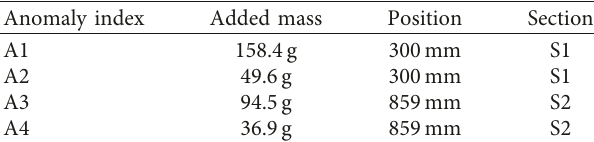
Figure 3: Magnitudes of lumped masses:158.4g; 94.5g; 49.6g; and 36.9g, respectively. Table 1: Structural anomalies scenarios.